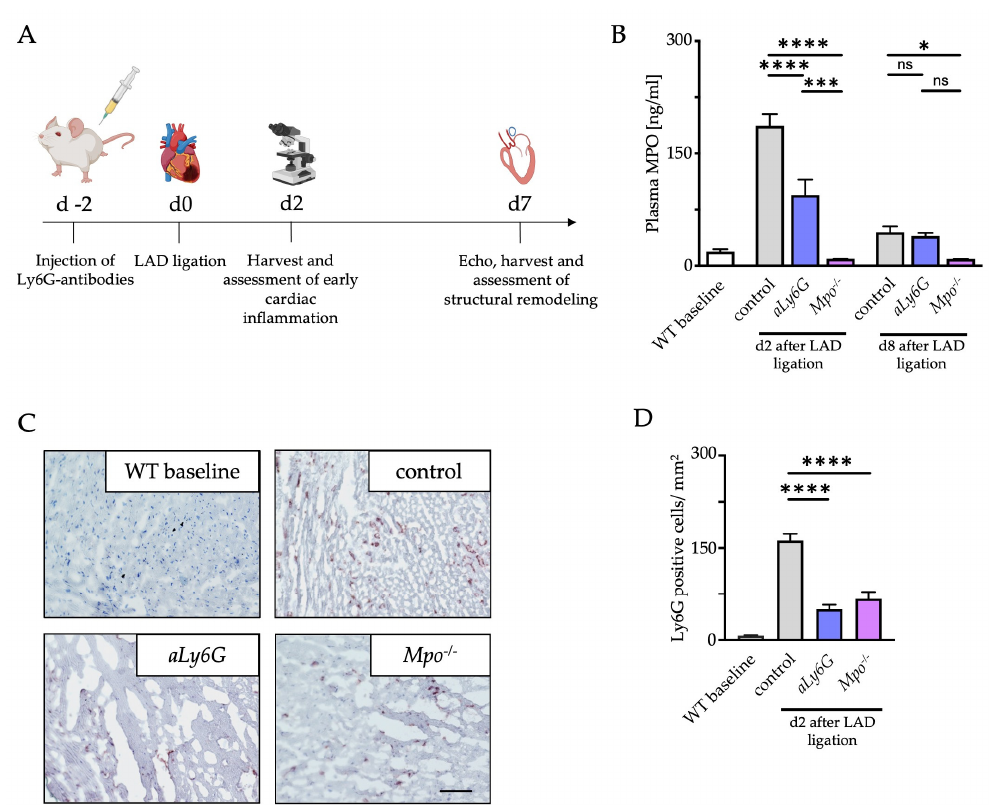
Figure 1. Polymorphonuclear neutrophil (PMN) reduction and myeloperoxidase (MPO) deficiency ( Mpo − / − ) alleviate inflammatory response after myocardial infarction (MI). ( A ) Schematic timeline of Ly6G antibody treatment, permanent left anterior descending artery (LAD) ligation (PI) and cardiac analyses: wildtype (WT) mice were treated with Ly6G antibodies 2 days before PI operation followed by cardiac investigations at days 2 and 7. ( B ) MPO plasma levels 2 and 8 days after PI assessed by ELISA. ( C ) Representative immunohistochemical Ly6G stainings (brown) of cardiac sections after 2 days of PI. Scale bar = 200 µ m. ( D ) Quantitative analysis of Ly6G positive cells within the infarct and peri-infarct region 2 days after PI. n = 5/5/5/5; * p < 0.05, *** p < 0.001, **** p < 0.0001, ns = not significant; one way ANOVA test followed by appropriate post hoc test, mean ± SEM is shown.